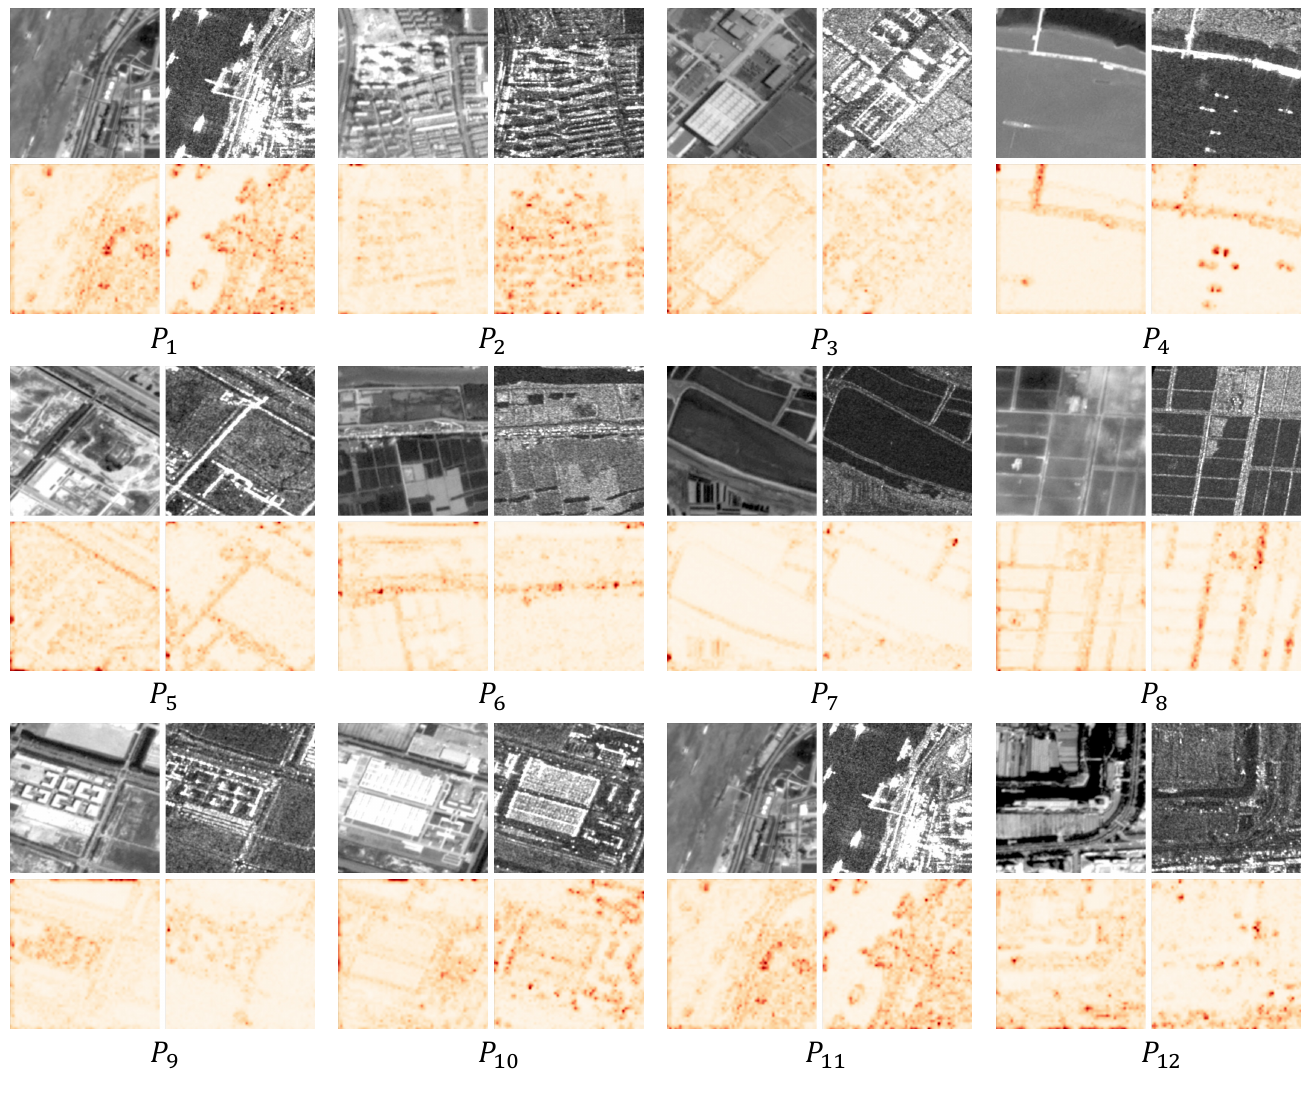
Figure 8. Qualitative comparison results on P 1 . . . P 12